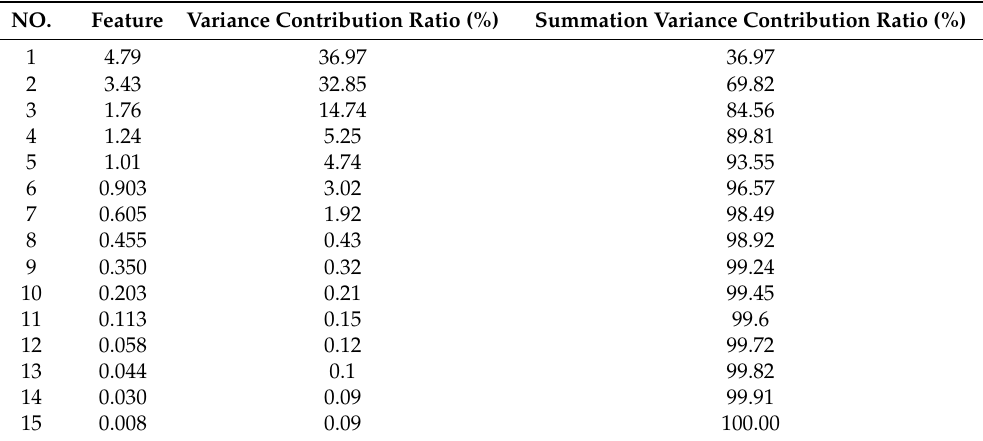
Table 2. Variance contribution ratio of each